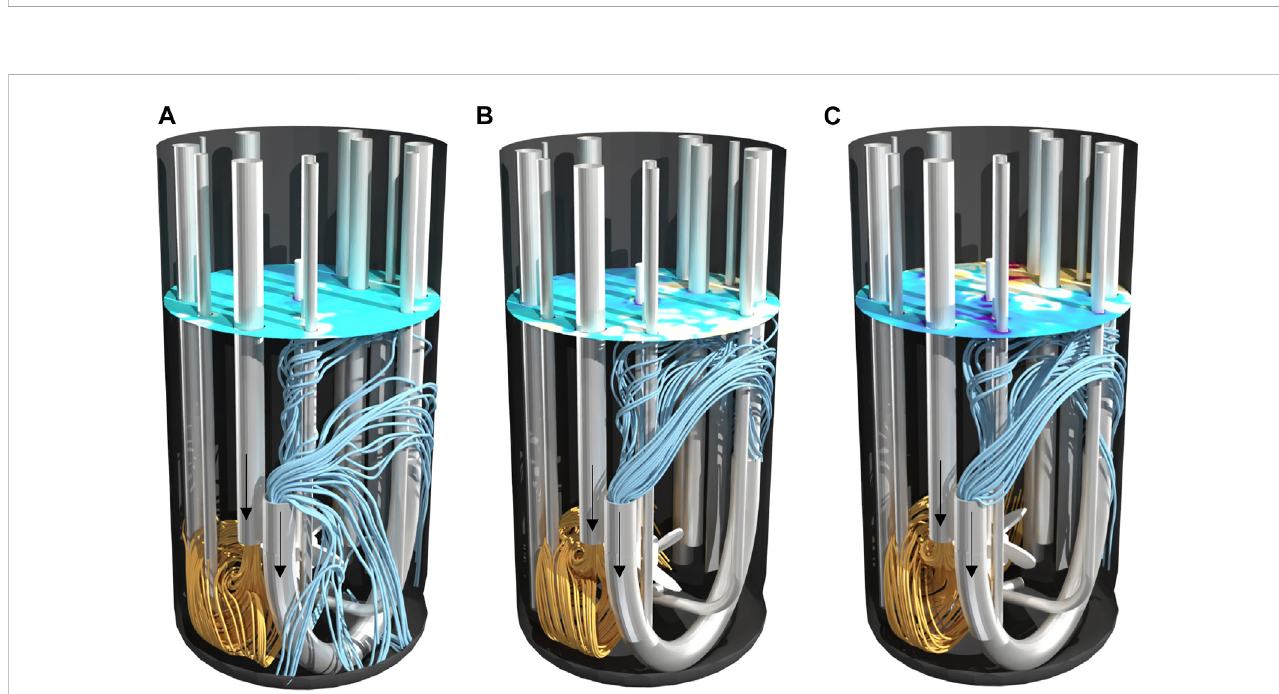
FIGURE 4 Streamlinesin2 LbioreactorofsetupIatdifferentpowerinputs (A) 10 W/m³, (B) 27 W/m³and (C) 58 W/m³.Streamlinescalculatedforwardsinorangeas in fl ow and streamlines calculated backwards in blue as out fl ow. The surface color indicates the topology of the